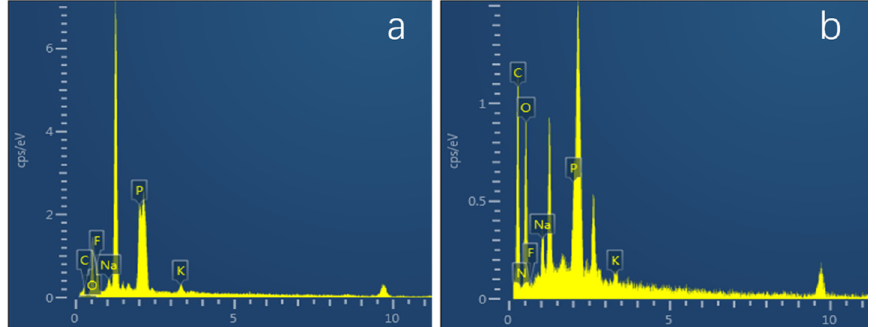
Figure 4. Fourier-transform infrared spectroscopy (FT-IR) spectrum of the AZ31, MAO + AZ31, AHEC + MAO + AZ31, and pure AHEC.